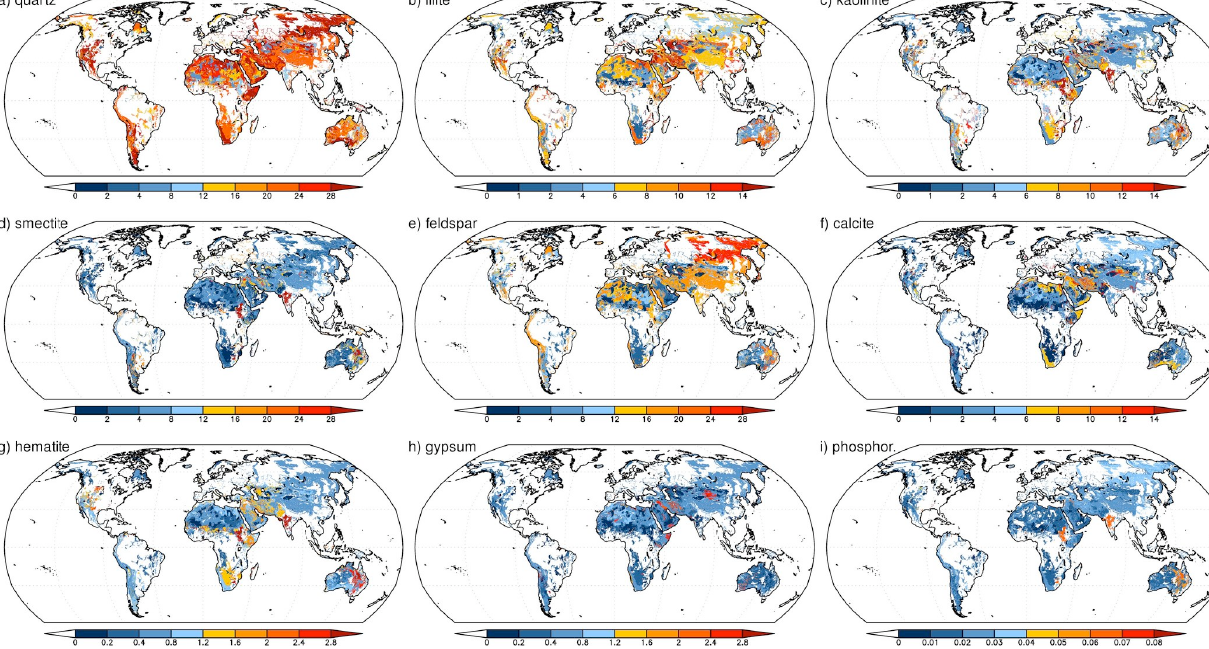
Fig. 4. Global distribution of the effective mineral content in soil in percentages for (a) quartz, (b) illite, (c) kaolinite, (d) smectite, (e) feldspar, (f) calcite, (g) hematite, (h) gypsum and (i) phosphorus. The mineral fraction is weighted with the clay and silt content in soil. For minerals that are present in both clay and silt, the weighted values are